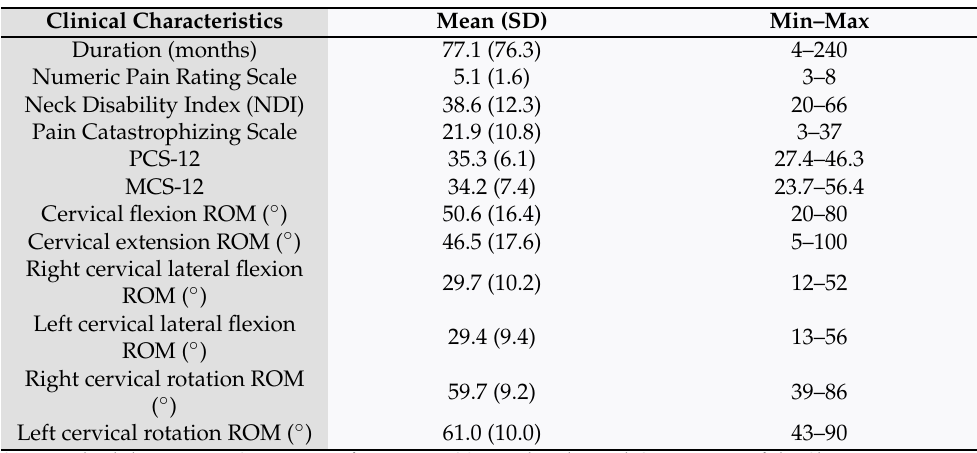
Table 1. Clinical characteristics of the participants ( n =